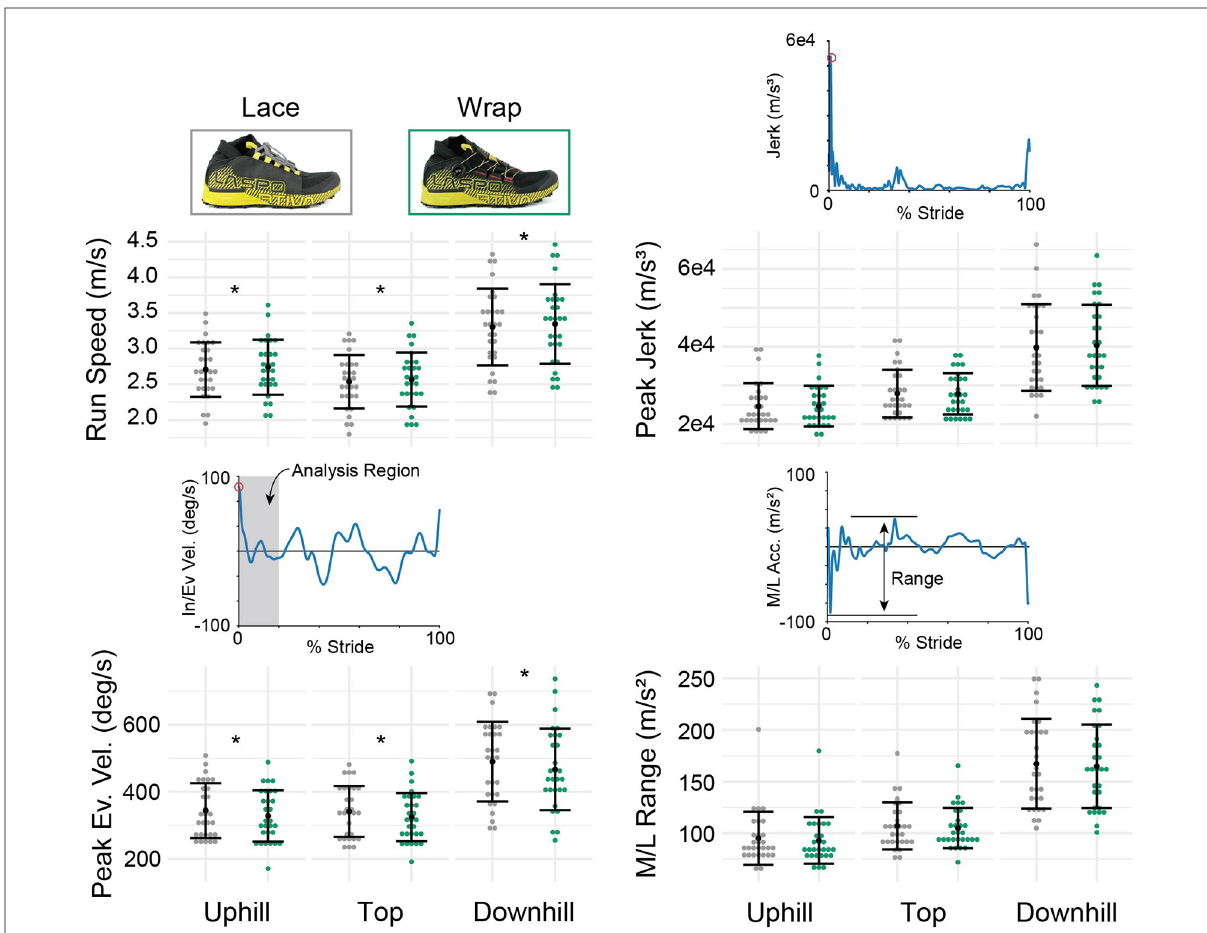
FIGURE 3 IMU-based outcomes. The individual dots represent subject-average results. The black dots and adjoining error bars represent study averages and standard deviations ( N =29). Asterisks (*) indicate signi fi cant differences between the Lace and the Wrap shoes for each of the different sections of the trail. Above the peak jerk, peak eversion velocity (Ev. Vel.), and medial/lateral acceleration range (M/L Range) are example curves from one subject and one stride to demonstrate how the metric was